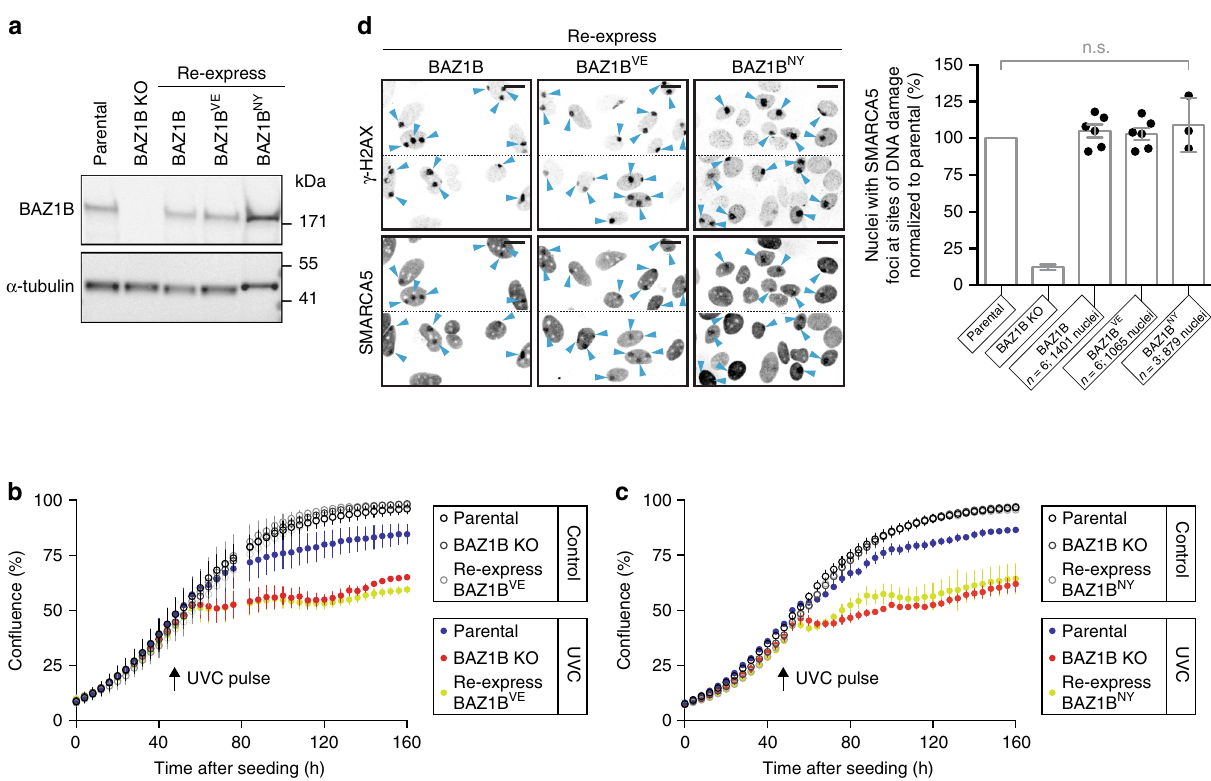
Fig. 5 The BD of BAZ1B is important for DNA damage recovery but dispensable for SMARCA5 recruitment. a Western blot analysis of BAZ1B expression in parental, BAZ1B -KO and BAZ1B -KO cells engineered to re-express wild-type BAZ1B, or the mutants BAZ1B VE (V1425E) and BAZ1B NY (N1419Y). b , c Con fl uence of the indicated cell line measured over time, before, and after a pulse of UVC light. d Accumulation of endogenous SMARCA5 at sites of DNA damage as in Fig. 2c, d. Scale bar , 20 μ m. Histograms represent the mean value ± s.e.m normalized to recruitment in parental cells. P- values were calculated using a two-tailed Mann – Whitney test; n.s . not signi fi cant ( P >